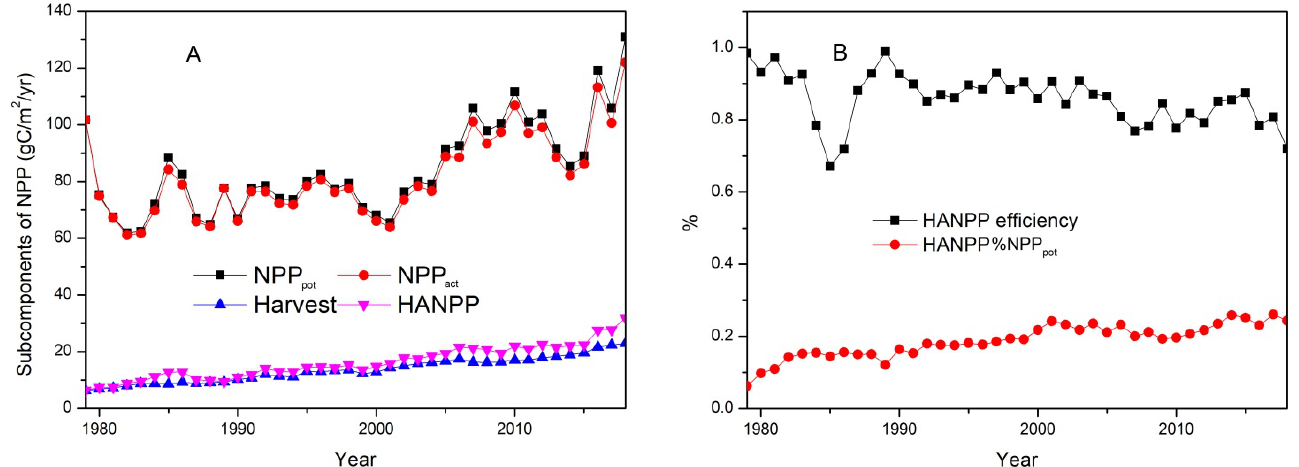
Figure 3. Interannual variations in the ( A ) components of NPP and ( B ) HANPP efficiency and HANPP%NPP pot (percentage that HANPP accounted for NPP pot ) in Qinghai grasslands in the period of 1979 to 2018 (NPP—net primary productivity; NPP pot —potential net primary productivity; NPP act —actual net primary productivity; HANPP—human appropriation of net primary productivity). Figure 3B shows the interannual variations in HANPP efficiency and